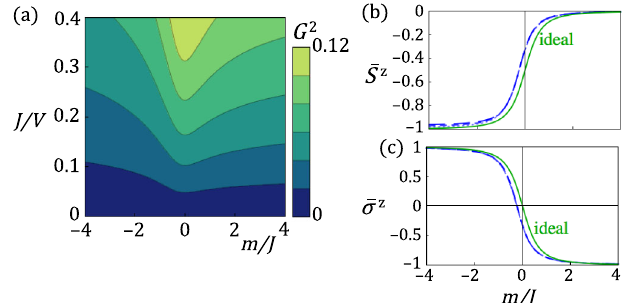
FIG. 10. Observables in the minimal implementation. (a) The gauge invariance is only violated substantially where V=J is not a þ S z Þ = 2 strong energy scale. The order parameters (b) (cid:1) S z (cid:7) ð S z 12 21 þ (cid:5) z Þ = 2 behave similarly to the ideal QLM and (c) (cid:1) (cid:5) z (cid:7) ð (cid:5) z 1 2 (solid line). The transition from a C - and P -invariant state to a C - and P -breaking state can be clearly seen. The blue curves from lighter to darker and shorter to longer dashes denote J=V ¼ 0 : 125 , 0.25, 0.275, but practically